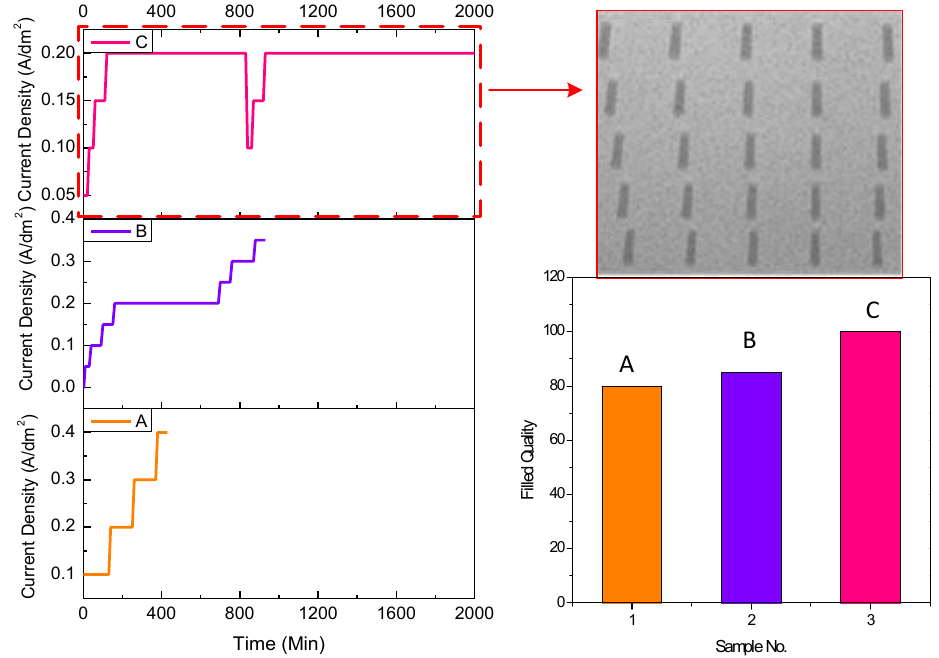
Figure 6. Illustration of the electroplating conditions and the filling quality of the samples 40 µm in diameter and 160 µm in depth. A , B , C are different electroplating conditions with various current densities and time shown in the figure.